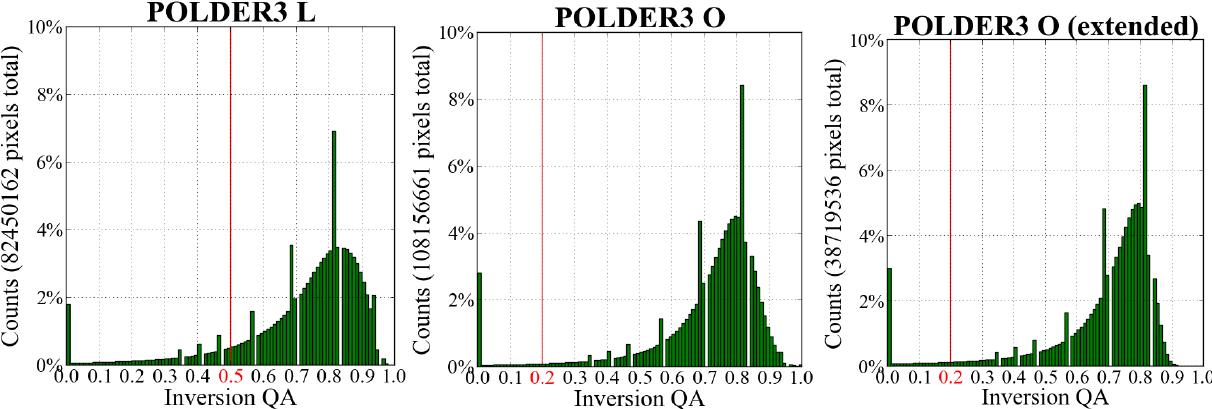
Fig. 3. The total quantities of POLDER3 land (“L”) and ocean (“O”) pixels based on different values of “quality of inversion” flag during the analyzed period of July 2006–December 2010. The “POLDER3 O (extended)” histogram is based on those pixels in ocean retrievals, where the retrieval algorithm considered the sensor viewing geometry conditions to be especially “favorable” and produced a set of additional aerosol parameters, such as spherical large-mode AOD, refractive index of fine mode, and others. The quality flag values are binned into 0.01 intervals, and the red lines indicate the 0.5 (land) and 0.2 (ocean) QA thresholds used in this study. Please note that even though certain retrievals can have a very high value of inversion QA (e.g., QA>0.9 in ocean retrievals), if they were retrieved under less than favorable conditions, they may not necessarily be high-quality aerosol data, as there are almost no extended ocean retrievals with QA>0.9.